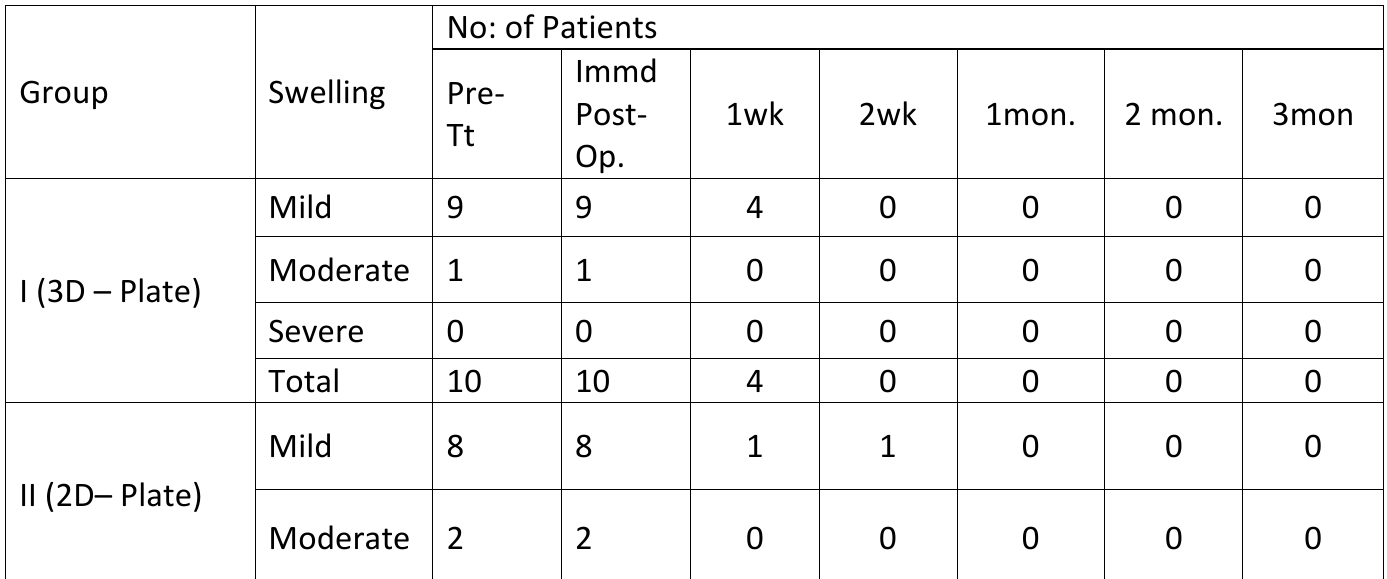
Table 3: Swelling in